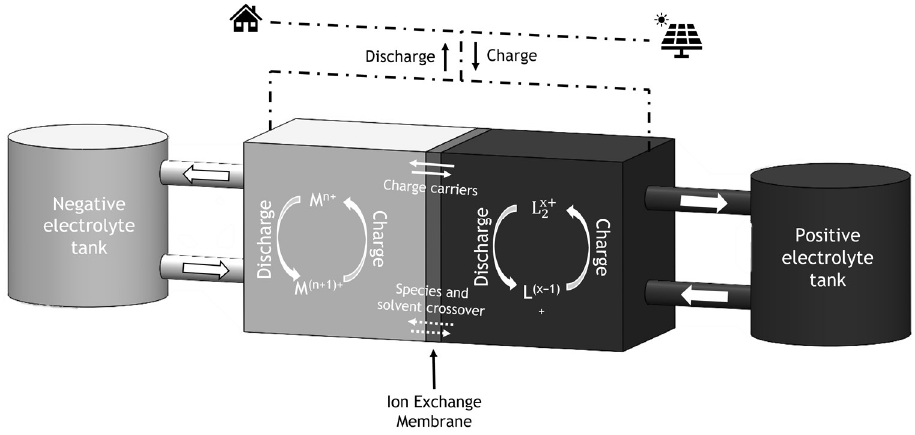
Figure 1. Schematic representation of an RFB.